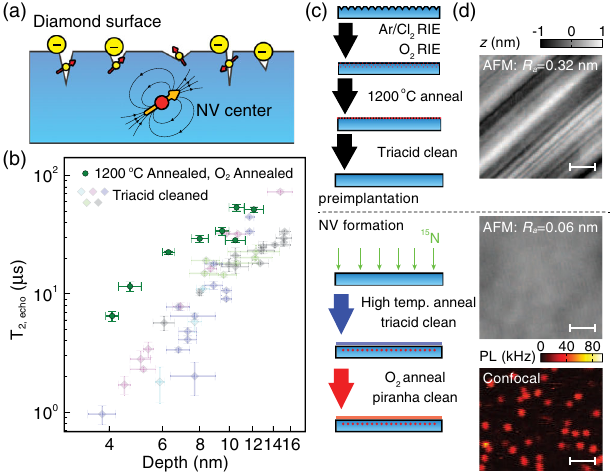
FIG. 1. Creation of shallow NV centers with long coherence times. (a) Schematic showing an NV center near the diamond surface. The surface can host defects that produce electric and magnetic field noise. (b) Hahn echo coherence time T 2 as a ; echo function of NV depth, measured across six samples with different surface conditions. Although the triacid-cleaned surfaces have different origins and processing histories (see Appendix A 1), the relationship between T 2 and depth is similar across all ; echo samples, and the high-temperature and oxygen-annealed sample exhibits significantly improved coherence times at the same depths. (c) Surface processing steps before implantation to remove surface polish damage and subsurface RIE damage, and after implantation to form NV centers and create a well- ordered oxygen surface termination. The high-temperature annealing step can be performed at 800° or 1200 °C. (d) AFM images of initial scaife-polished diamond (top) and the final surface after oxygen annealing (middle); scale bar is 100 nm. Confocal image (bottom) showing photoluminescence (PL) from individually resolvable NV centers; scale bar is 1 μ